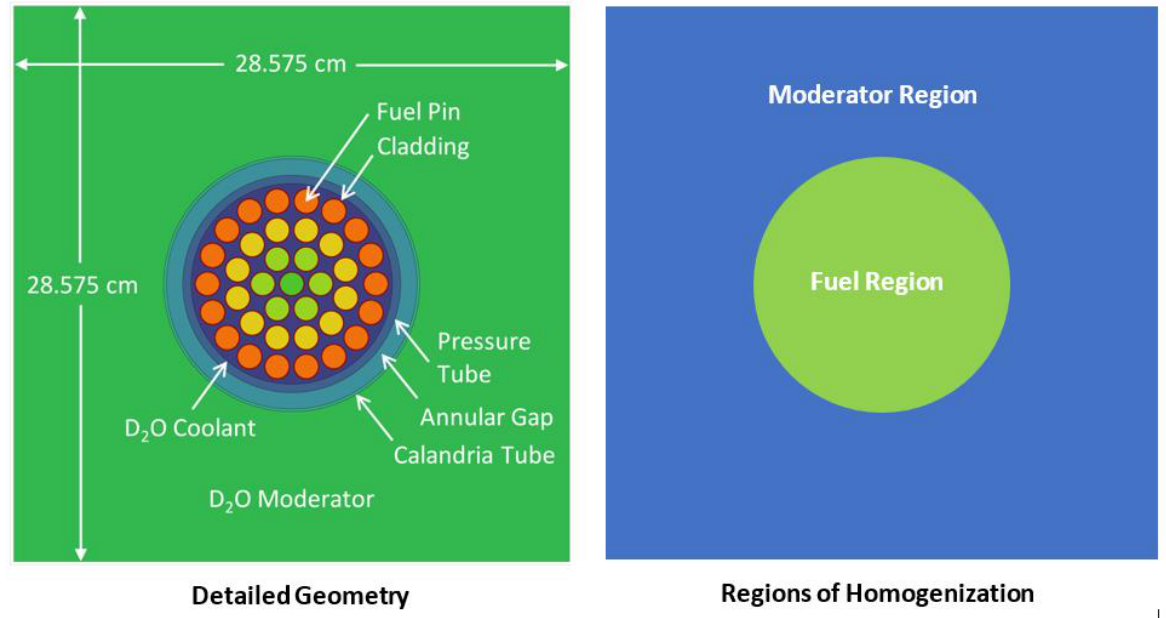
Figure 1. PHWR Fuel